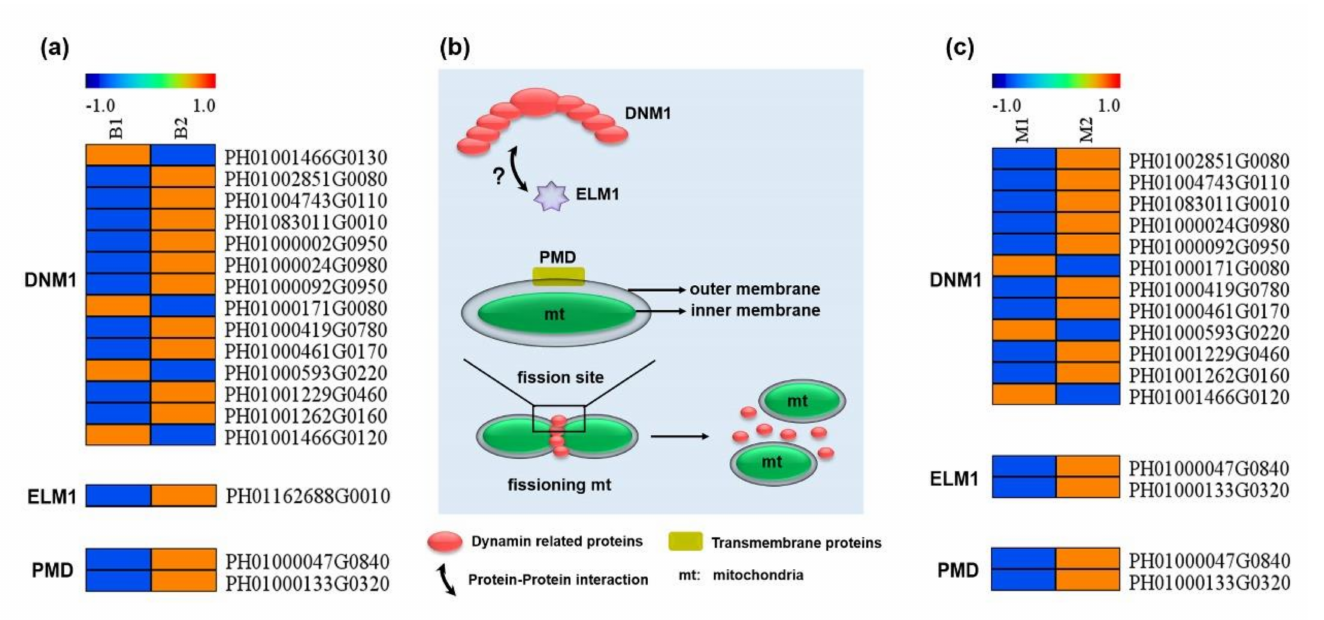
Figure 4. DEGs related to mitochondrial fission and the model of mitochondrial fission during shoot growth in Moso bamboo. Key DEGs related to mitochondrial fission in total ( a ) and mitochondrial ( c ) transcriptome. ( b ) The model of mitochondrial fission during shoot growth in Moso